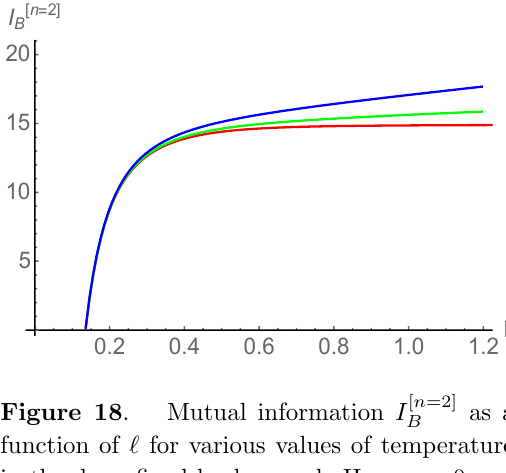
as a Figure 19 . Mutual information I [ n =2] B a function of ‘ for various values of chemical potential in the decon(cid:12)ned background. Here T = 1 : 2 T c and x = 0 : 1 are (cid:12)xed and red, green, blue and brown curves correspond to (cid:22) = 0, 0 : 15, 0 : 30 and 0 : 45 respectively. In units